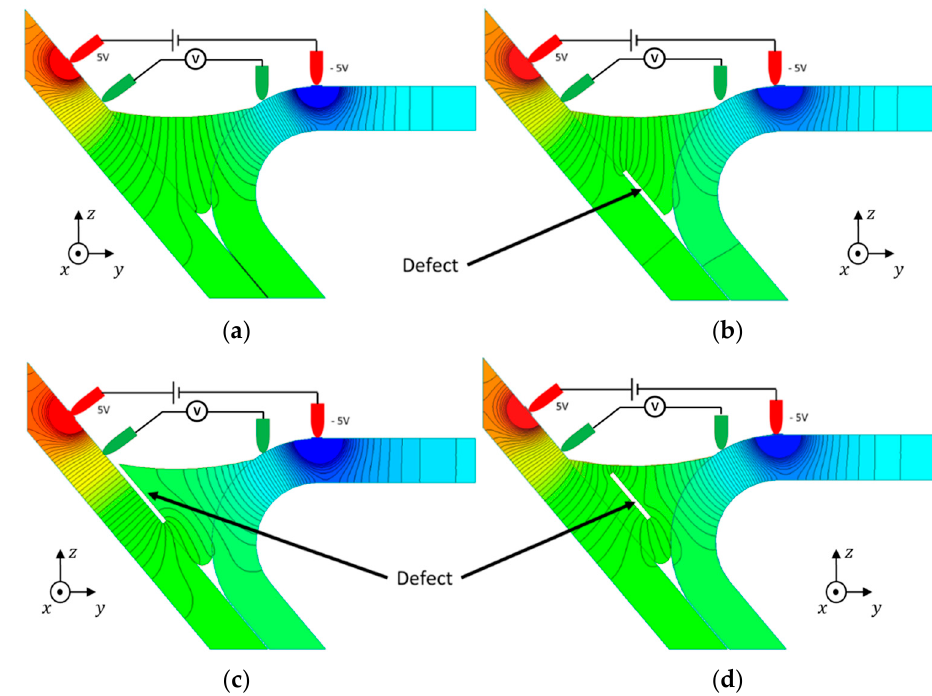
Figure 5. Electric equipotential lines along the current flow direction for different defect locations.